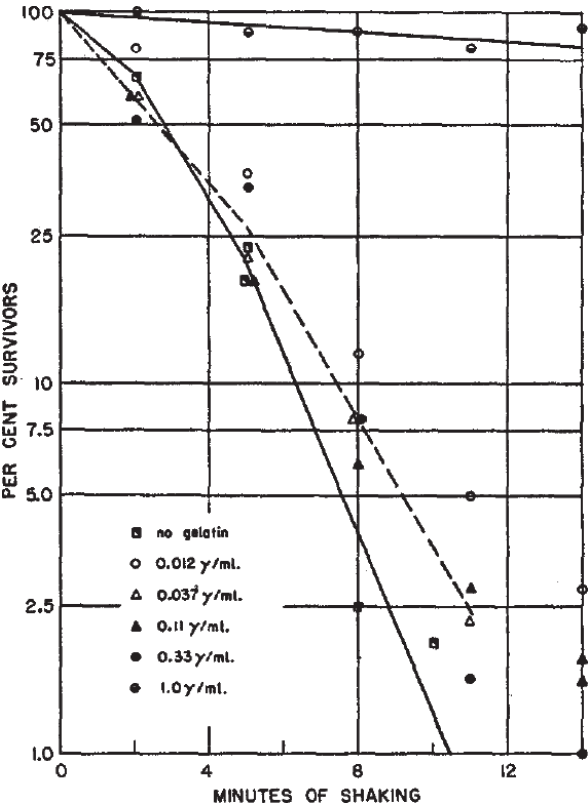
Figure 3. The inactivation of phage T 5 , shaken in the presence of various amounts of gelatin which had already been shaken for 15 minutes before addition of phage. The symbols correspond to the same gelatin concentrations as in Fig. 2. The solid line is the curve for no added gelatin and the dotted line is an average curve for the tubes containing added gelatin.